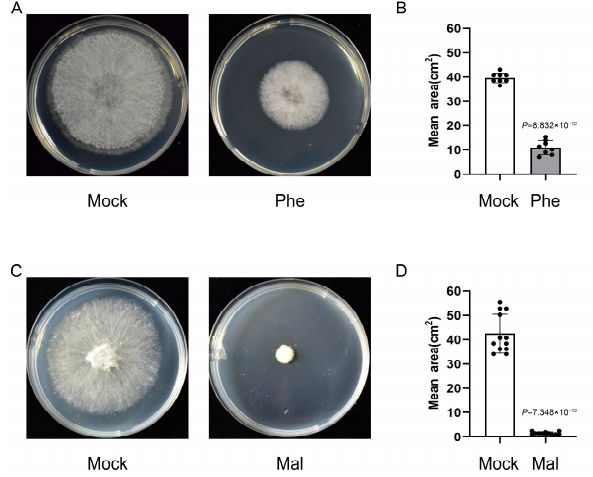
Figure 6. Antifungal effects of phenylalanine and malate. ( A ) Growth of the F. graminearum strain Fg1312 on potato dextrose agar (PDA) cultures with 5 mM Phenylalanine or mock as control at 25 °C for 3 d. ( B ) Statistical analysis of colony growth area of the Fg1312 strains on respective media. Error bars represent standard deviation from 8 independent experiments. ( C ) Growth of the F. graminearum strain Fg1312 on potato dextrose agar (PDA) cultures with 5 mM malate or mock as control at 25 °C for 3 d. ( D ) Statistical analysis of colony growth area of the Fg1312 strains on respective media. Error bars represent standard deviation from 12 independent experiments.